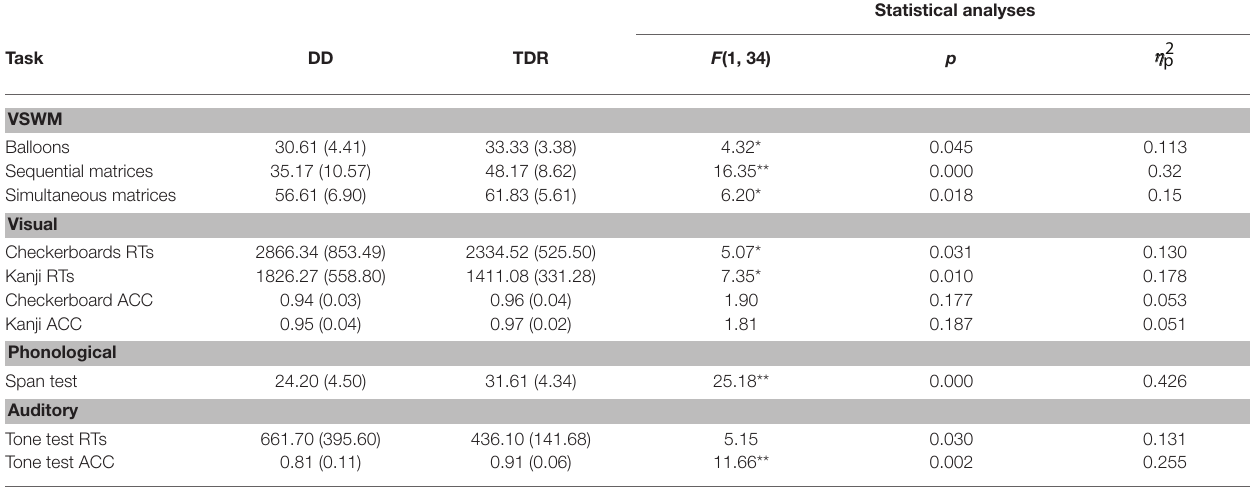
TABLE 1 | Mean and standard deviations (SD) in all tasks.